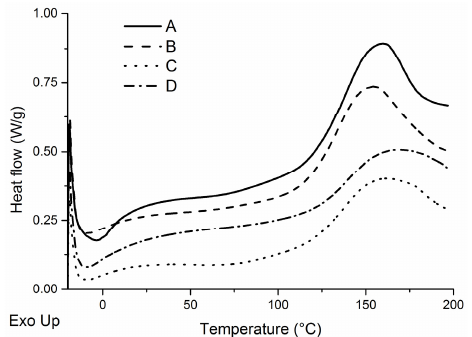
Figure 6. Differential Scanning Calorimetry results for dried products from emulsions containing ( A ) 80 wt.%, ( B ) 70 wt.%, ( C ) 55 wt.%, and (D) 40 wt.% of tung oil after heating at 100 °C for 24 h.